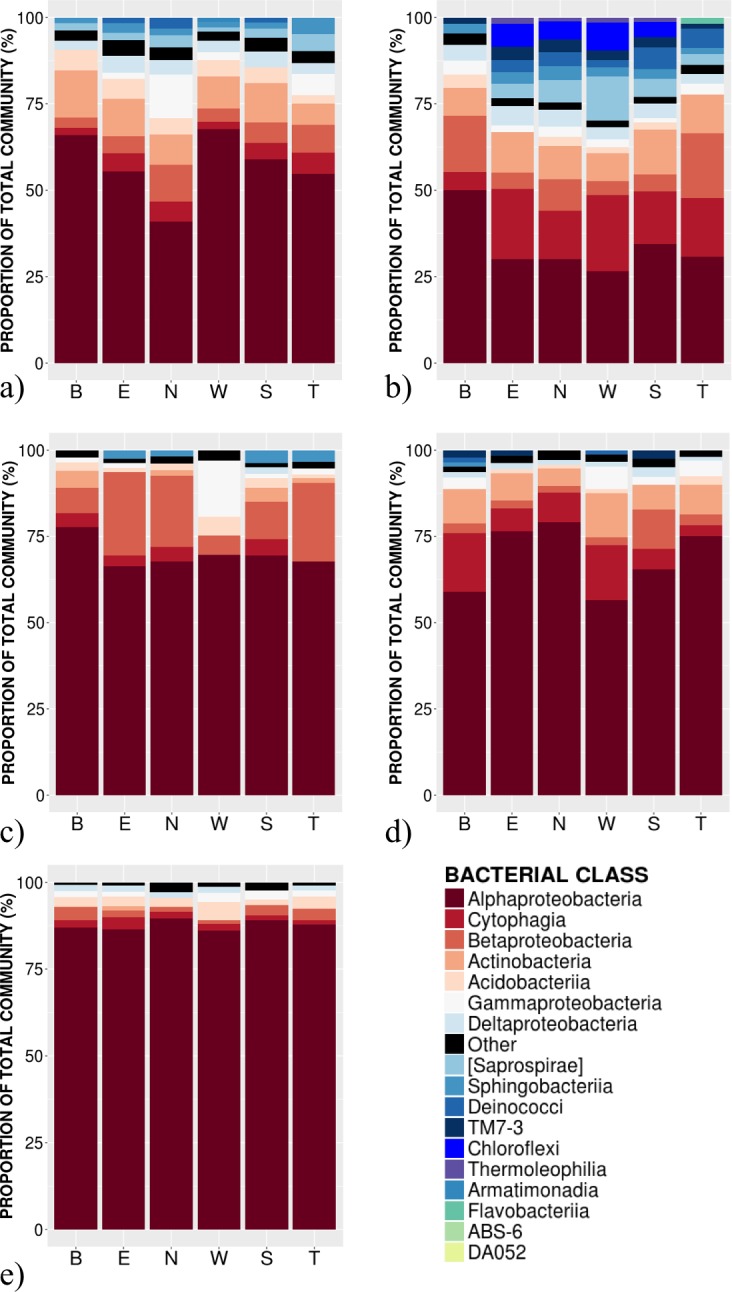
Relative abundance of bacterial classes in the phyllosphere at 6 canopy locations (B:Bottom, E:East, N:North, W:West, S:South T:Top) for one individual of the five temperate tree species under study.(A) Abies balsamea; (B) Picea glauca; (C) Acer rubrum; (D) Acer saccharum; and (E) Betula papyrifera.